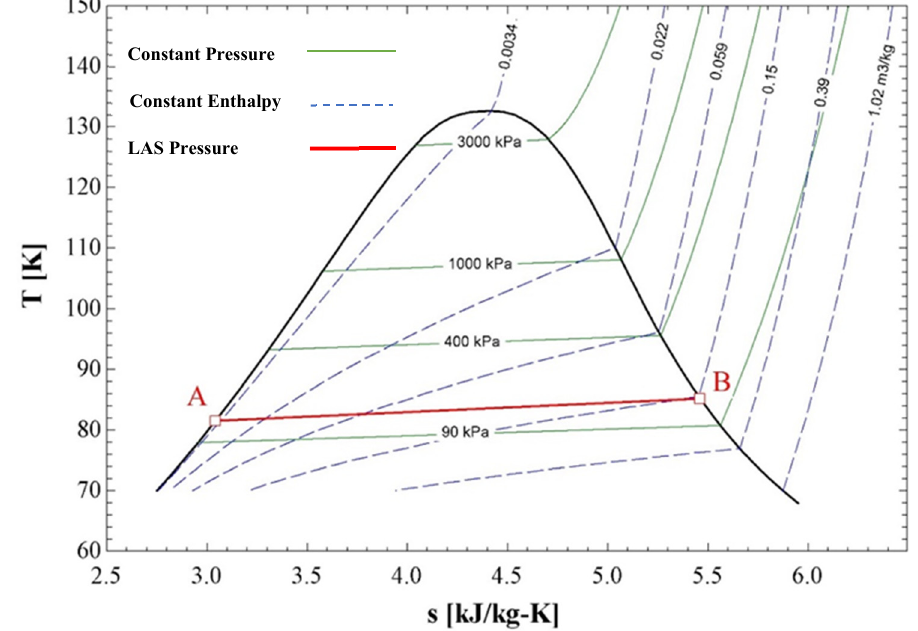
Figure 7. T–S properties diagram of air, presenting the thermodynamic condition of the tank in complete (A) and empty condition (B) .